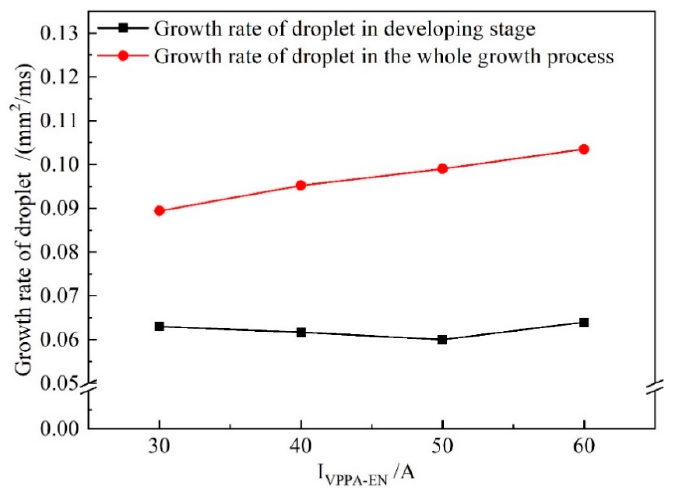
Figure 10. The growth rate of droplet cross-sectional area in the developing stage and during the whole growth process when I VPPA-EN is increased and I MIG-EN is fixed at 70 A.